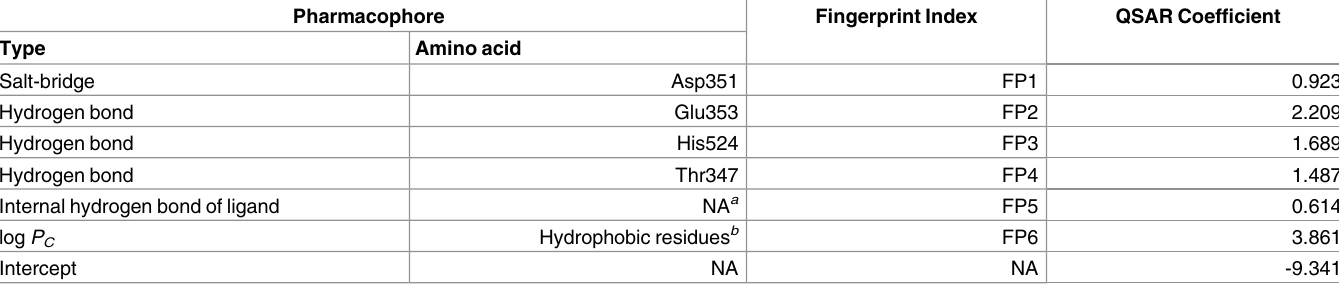
Table 1. Summaryof pharmacophore, fingerprint, and QSAR model parameters.